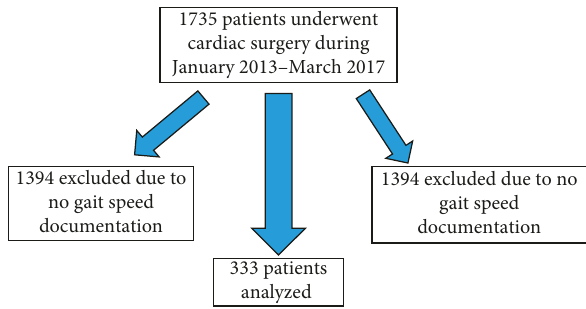
Figure 1: Schematic representation of enrollment process in- cluding the two exclusion